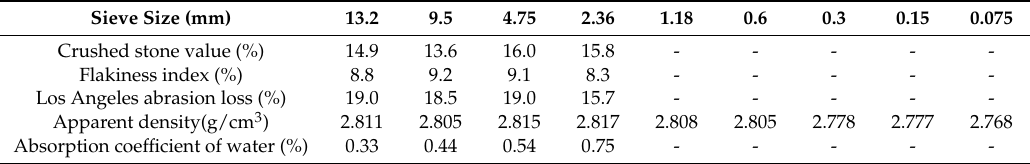
Table 2. Properties of aggregate.